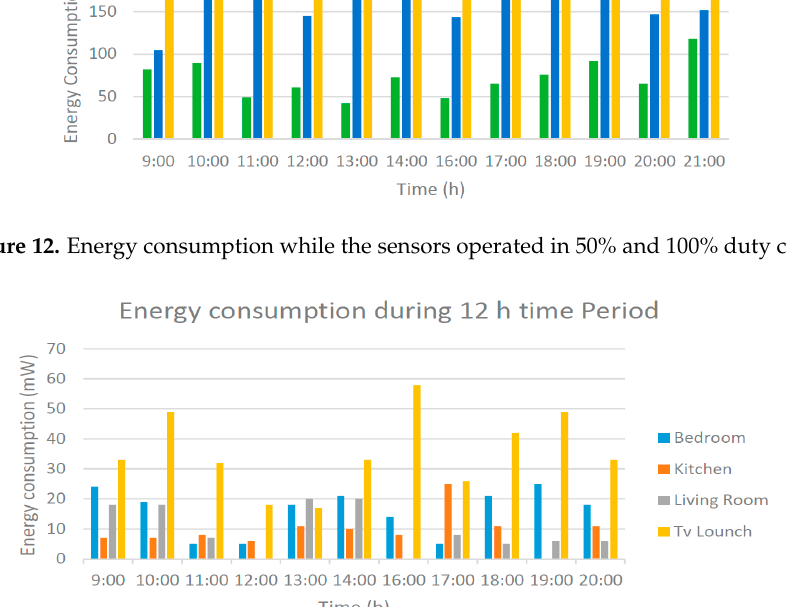
Figure 13. Energy consumption of the sensors during 12 h.